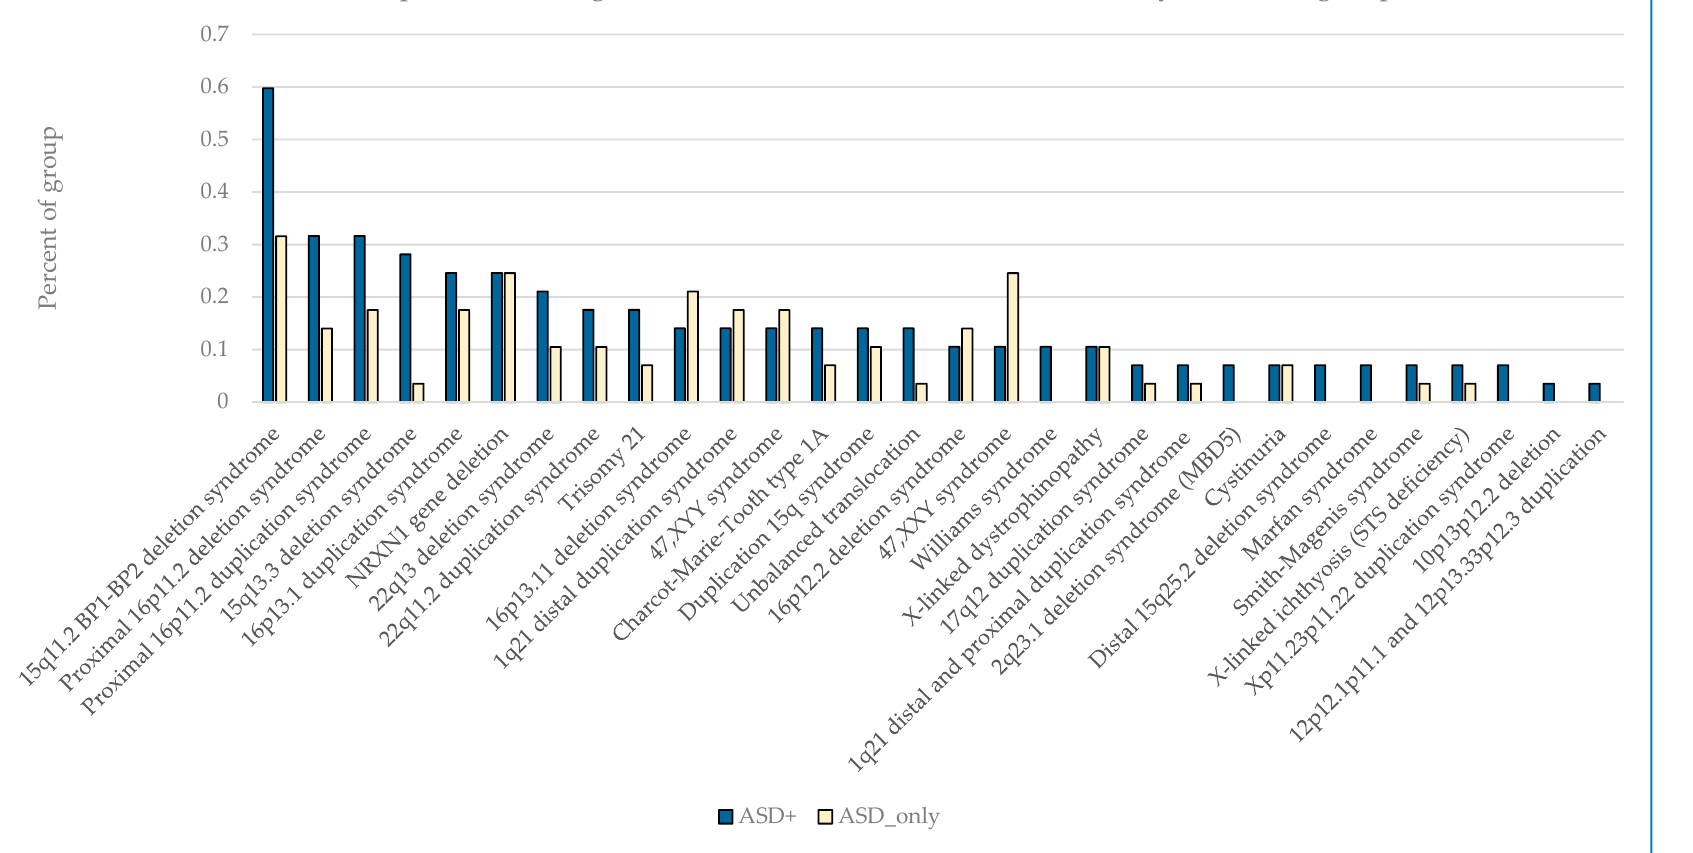
Figure 2. Relative frequencies of diagnoses in the ASD+ ( n = 2844) and ASD only ( n = 2850) groups.